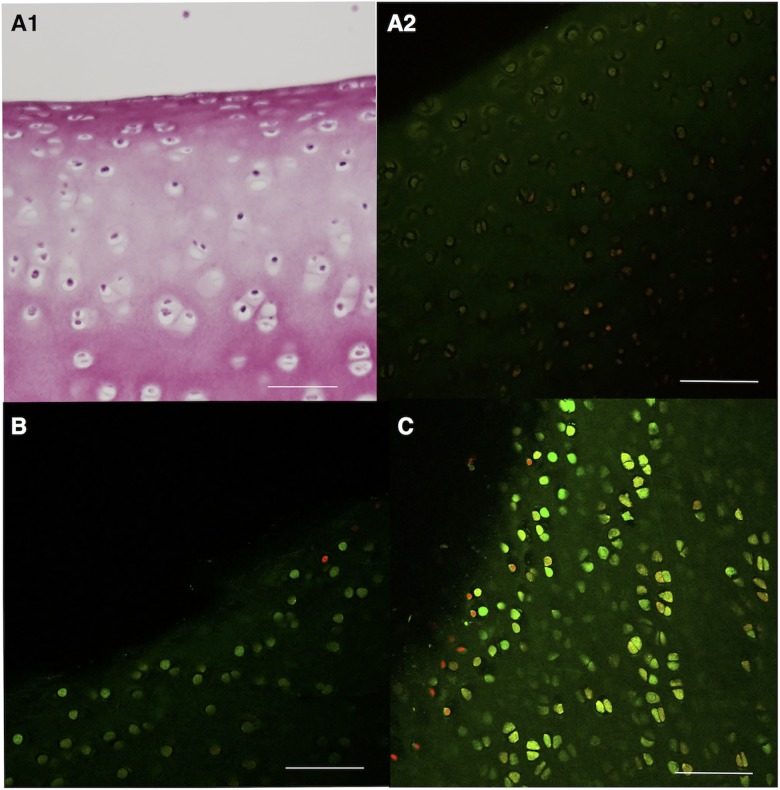
Cell viability after whole organ or tissue culture.Panel A1: H&E stain of a cartilage sample from a porcine conditioned joint also shown in Panel A2. Panel A2: Composite live/dead cell stain of cartilage from a conditioned porcine joint (after 2 weeks of whole organ culture). There is co-localisation of CMFDA (live; green) and propidium iodide (dead; red) signal but chondrocytes in superficial cartilage layers are predominantly CMFDA positive. Panel B: Live/dead cell staining of an equine cartilage sample exposed to low dose SPIONs (Group L). Panel C: Live/dead cell staining of an equine cartilage sample neither exposed to nanoparticles nor control vehicle solution (bar in panels = 80 μm).